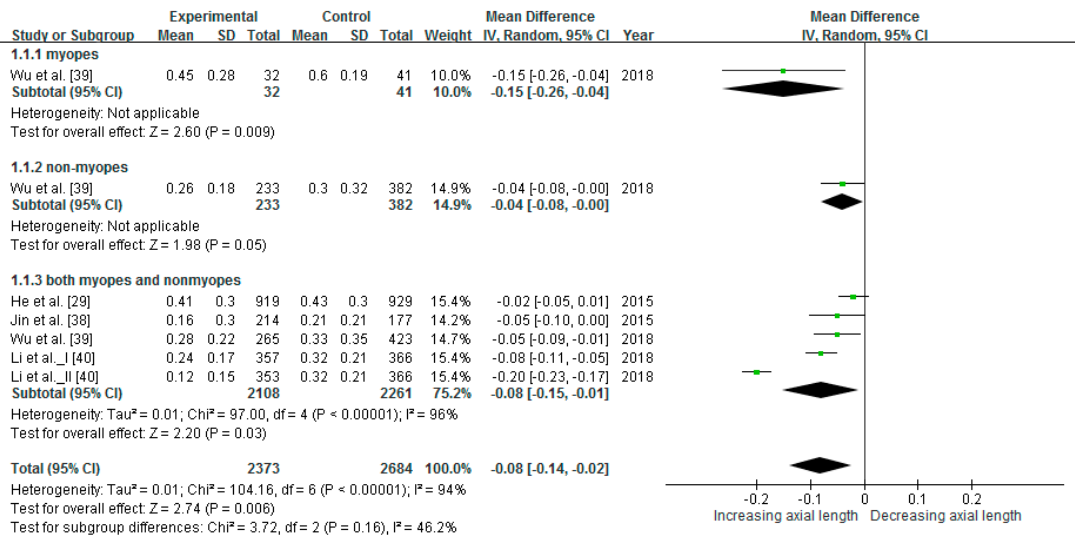
Figure 4. Results of the meta-analysis for axial elongation after intervention.